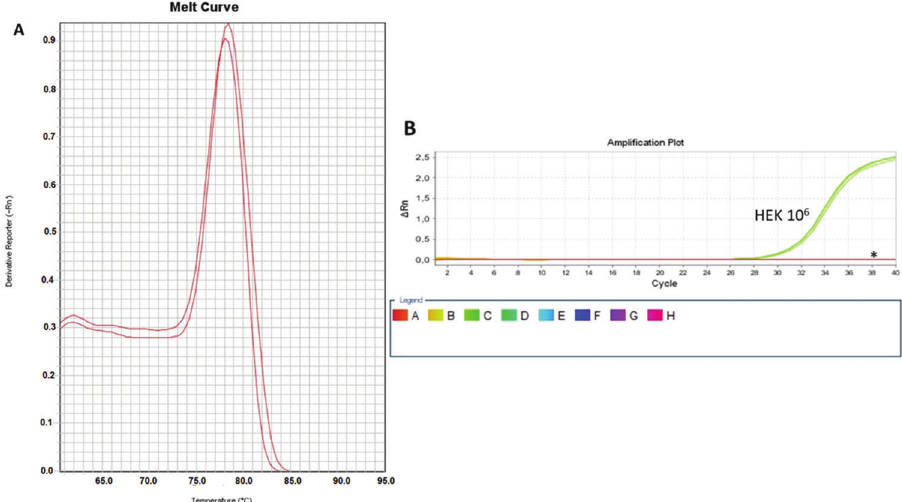
Figure 2 - Amplification and Specificity Test of HEK Cell Line Lysate. qPCR assay to assess telomerase activity in HEK cell lysates. A representative plot of 10 6 cell lysate amplification. A : Melting curve of qPCR run showing one product of amplification. B : Amplification of the 106-cell lysate plot showing a well-defined exponential linearity and a plateau demonstrating that the sample reached the limit of the equipment warranting sample positivity. Negative controls were represented by CHAPS lysis buffer and ultrapure water (*).